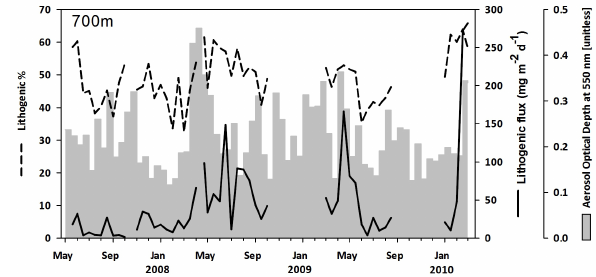
Fig. 10. Time-depth contour plot of the salinity evolution in the up- per 500m as recorded by the Poseidon Buoy (shown in Fig. 1) at NESTOR site.